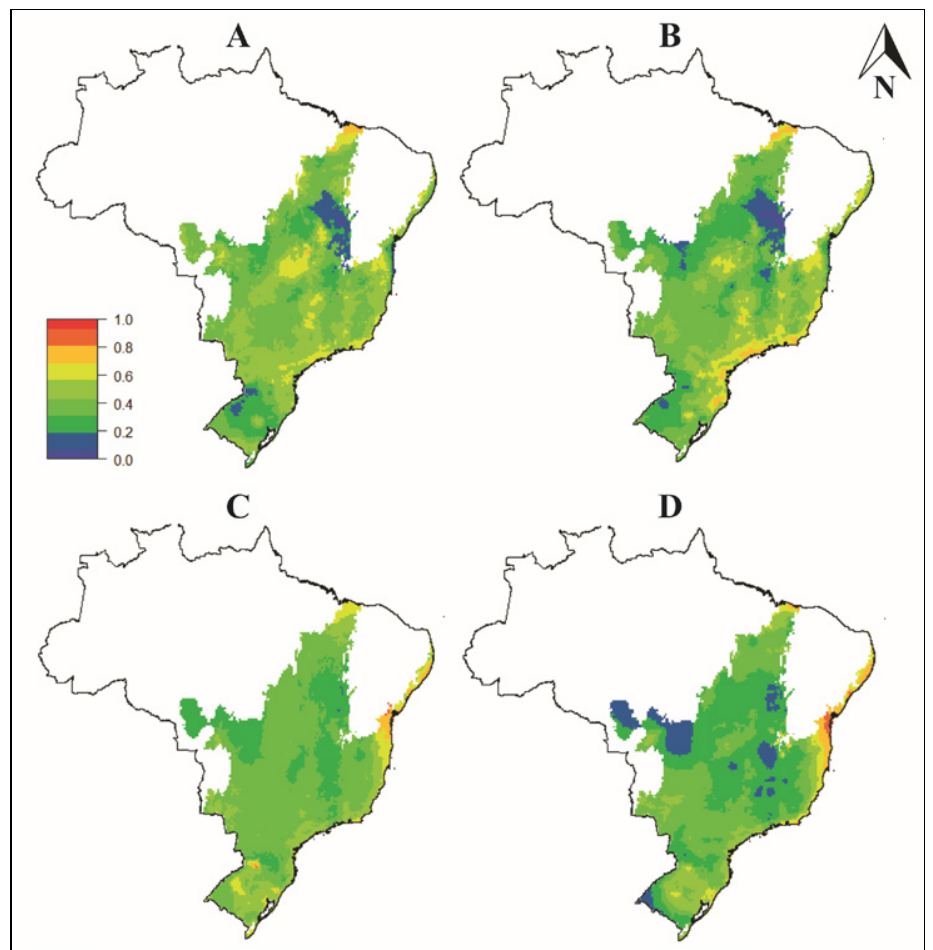
Fig 2 . Potential distribution of Melipona quadrifasciata anthidioides (A. current, B. future) and Melipona quadrifasciata quadrifasciata (C. current, D. future) in the Atlantic Forest, Pampa, and Cerrado biomes in